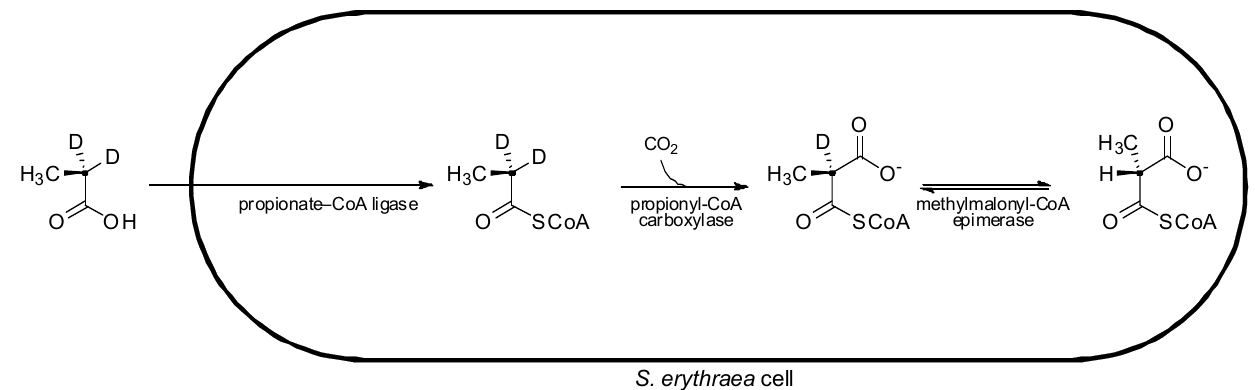
,2- 13 C]propionate, to S. erythraea 2